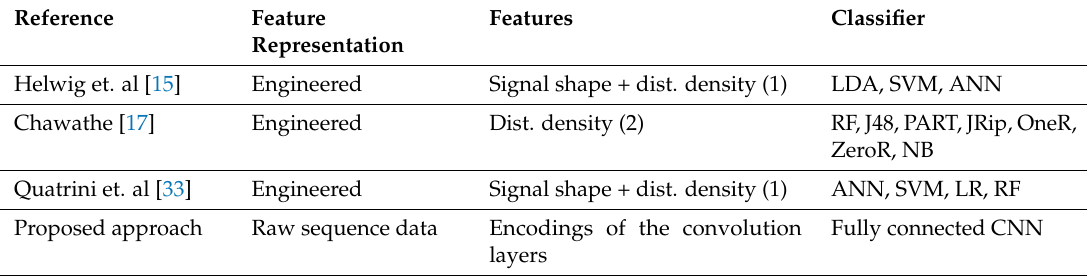
Table 3. Summary of related work. Signal shape features contain slope of linear fit and position of maximum value. Dist. density (1) refers to distribution density characteristics which are median, variance, skewness and kurtosis. In dist. density (2) mean is used instead of median. Classifiers abbreviations are as follows: linear discriminant analysis (LDA), support vector machines (SVM),